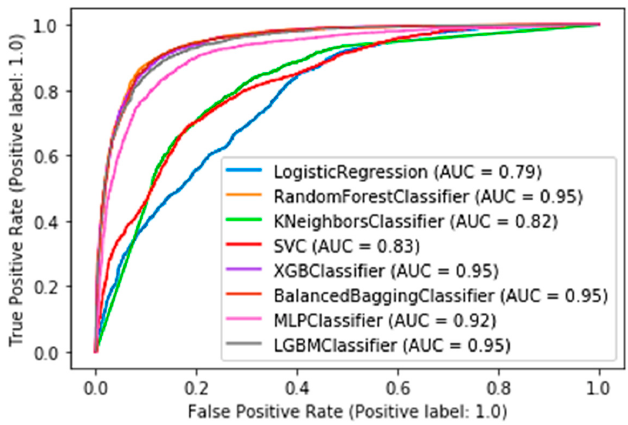
Figure 2. Roc curves of the competitive ML models.